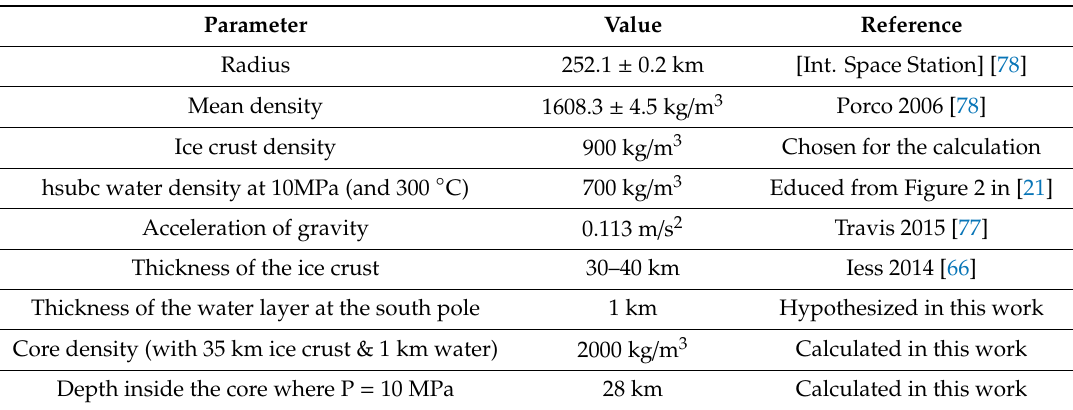
Table 3. Enceladus